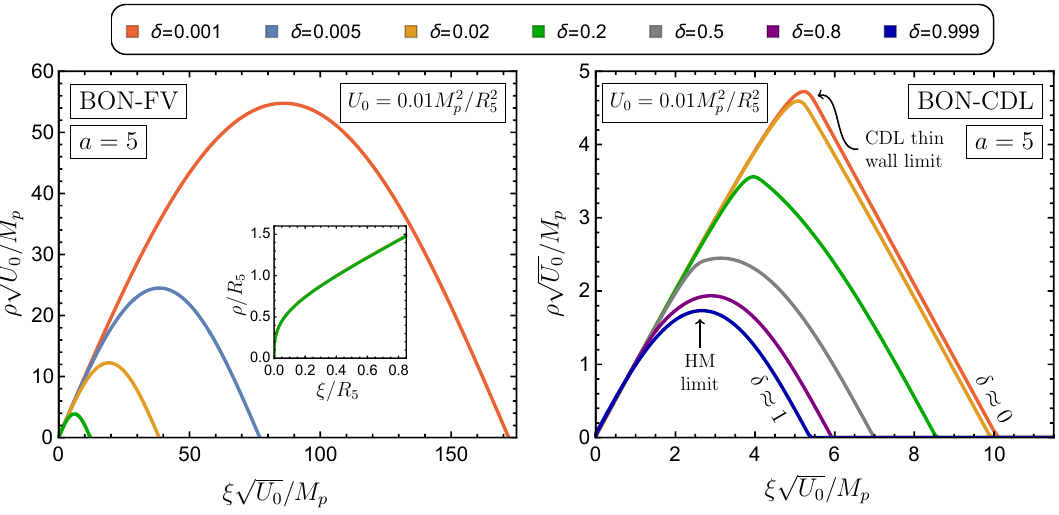
Figure 31: ⇢ ( ⇠ ) with inset Left: BON-FV Right: BON-CdL = 0 . 01 on the BON-FV ( left ) and BON-CDL ( right ) Figure 11 . Profiles for ρ ( ξ ) for U 0 R 2 /M 2 p 5 branches. For the BON-FV branch the solutions for ρ ( ξ ) are nearly identical to the false vacuum solution ρ ( ξ ) for ξ . This encompasses the majority of the domain 0 ≤ ξ ≤ ξ & R 5 fv 15